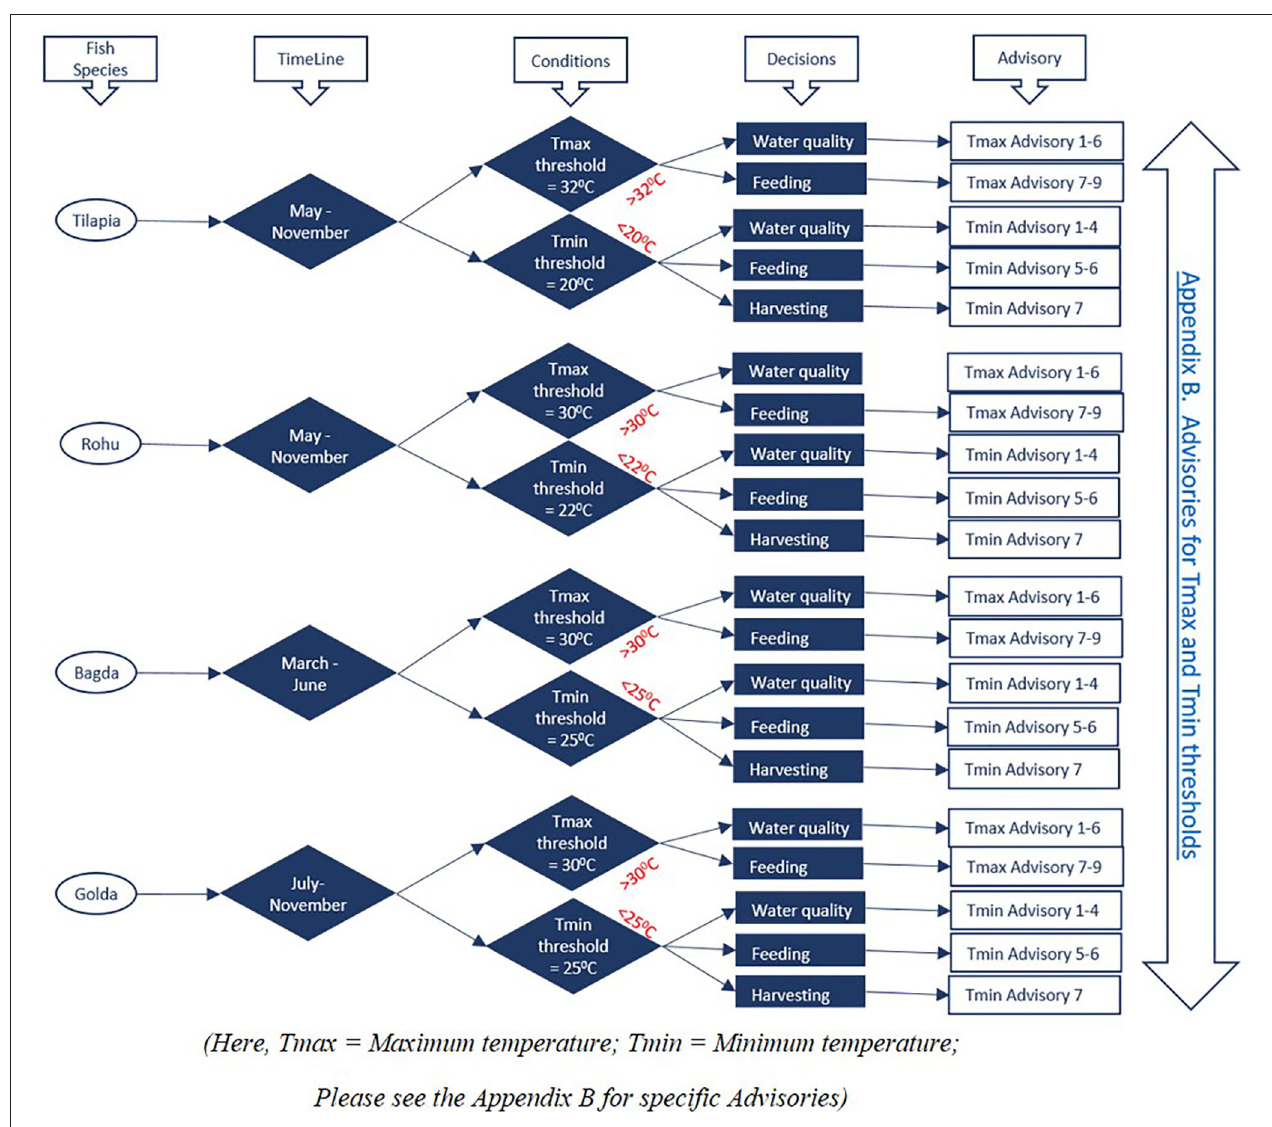
FIGURE 10 | Decision framework based on temperature thresholds for four widely cultivated aquatic species in